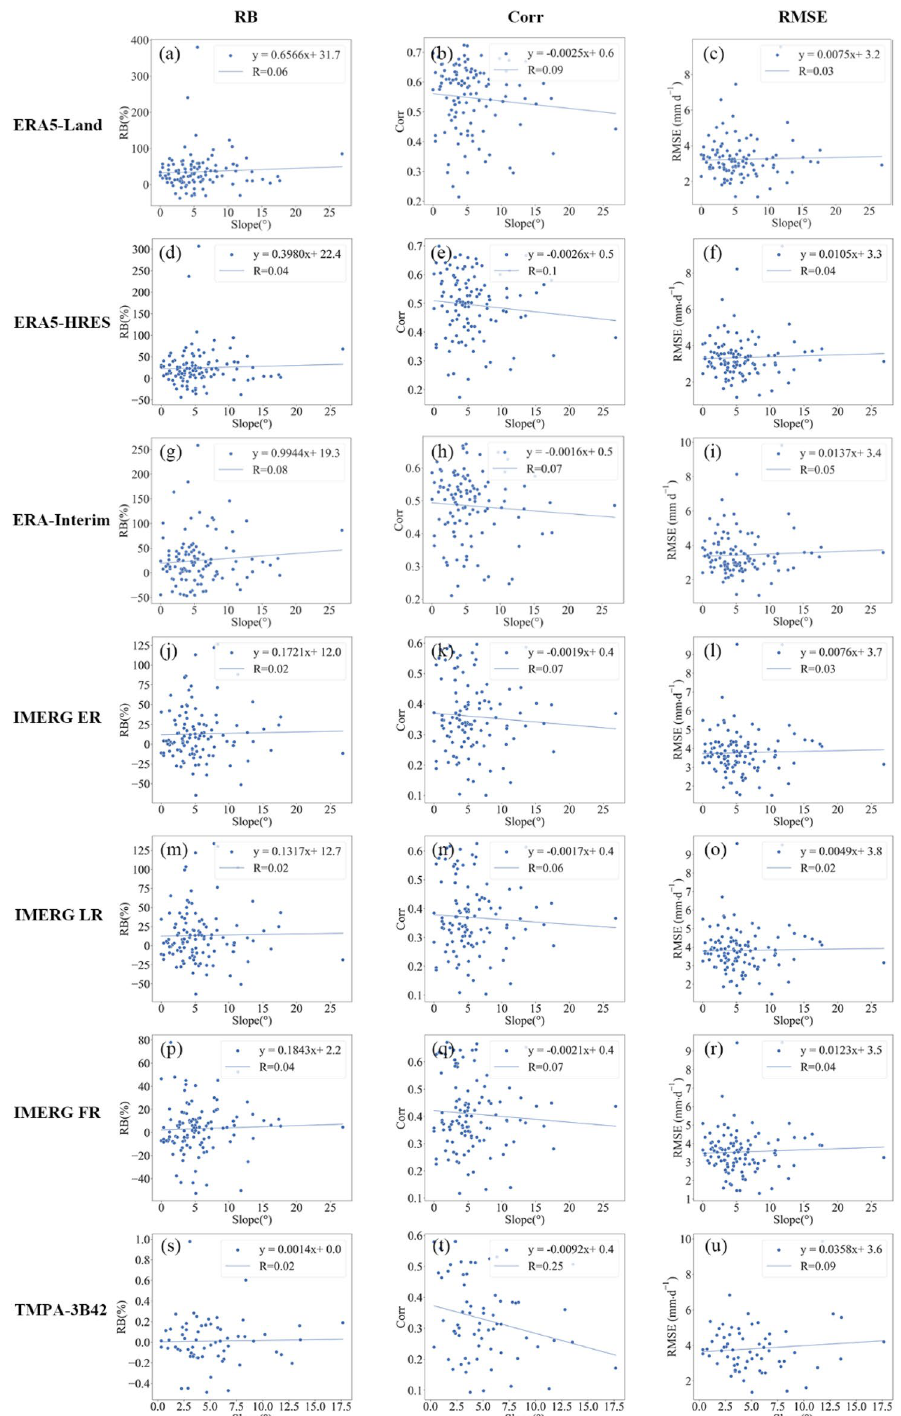
Figure 16. Changes in accuracy metrics with slopes. The subplots are RB for ( a ) ERA5-Land, ( d ) ERA5-HRES, ( g ) ERA-Interim, ( j ) IMERG ER, ( m ) IMERG LR, ( p ) IMERG FR, ( s ) TMPA-3B42; Corr for ( b ) ERA5-Land, ( e ) ERA5-HRES, ( h ) ERA-Interim, ( j ) IMERG ER, ( n ) IMERG LR, ( q ) IMERG FR, ( t ) TMPA-3B42; and RMSE for ( c ) ERA5-Land, ( f ) ERA5-HRES, ( i ) ERA-Interim, ( l ) IMERG ER, ( o ) IMERG LR, ( r ) IMERG FR, ( u )